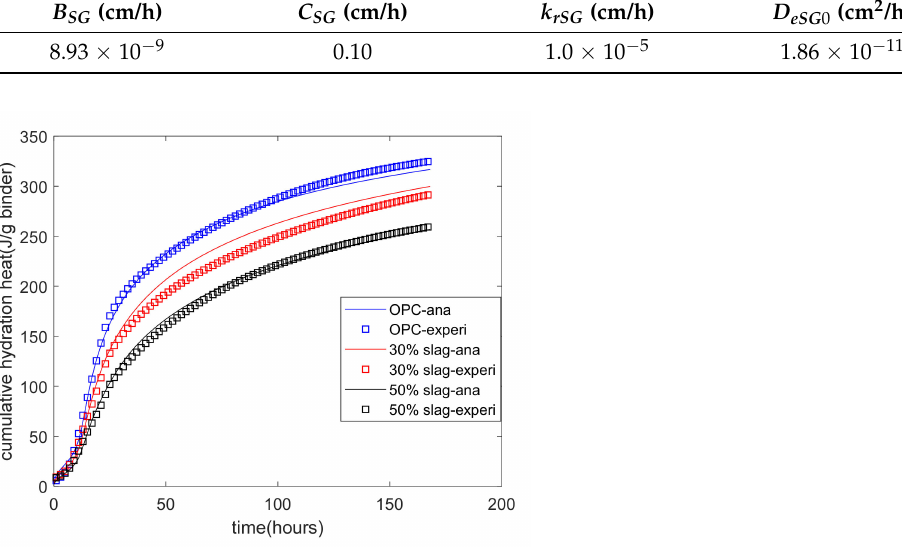
Figure 4. Analysis results for the cumulative hydration